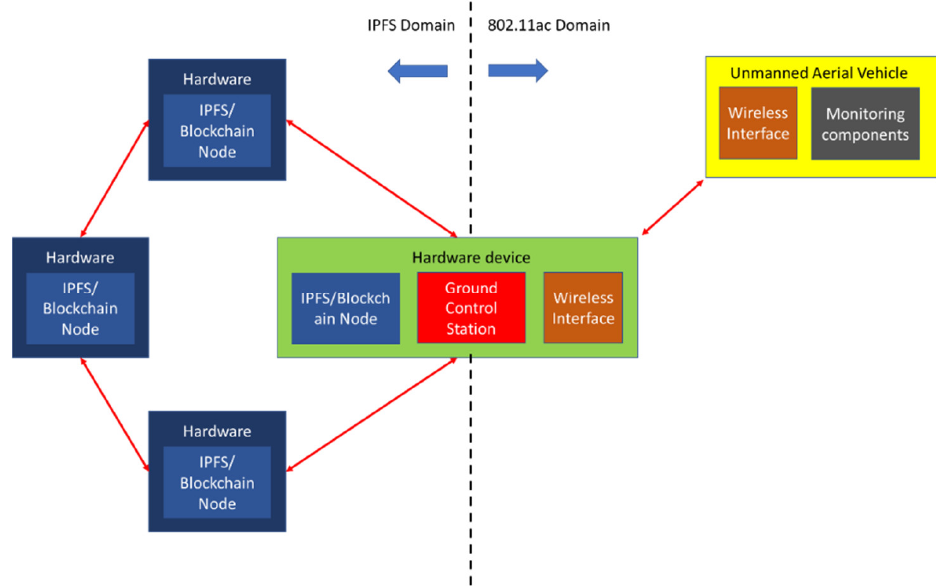
Figure 3. Software components use in the proposed system.